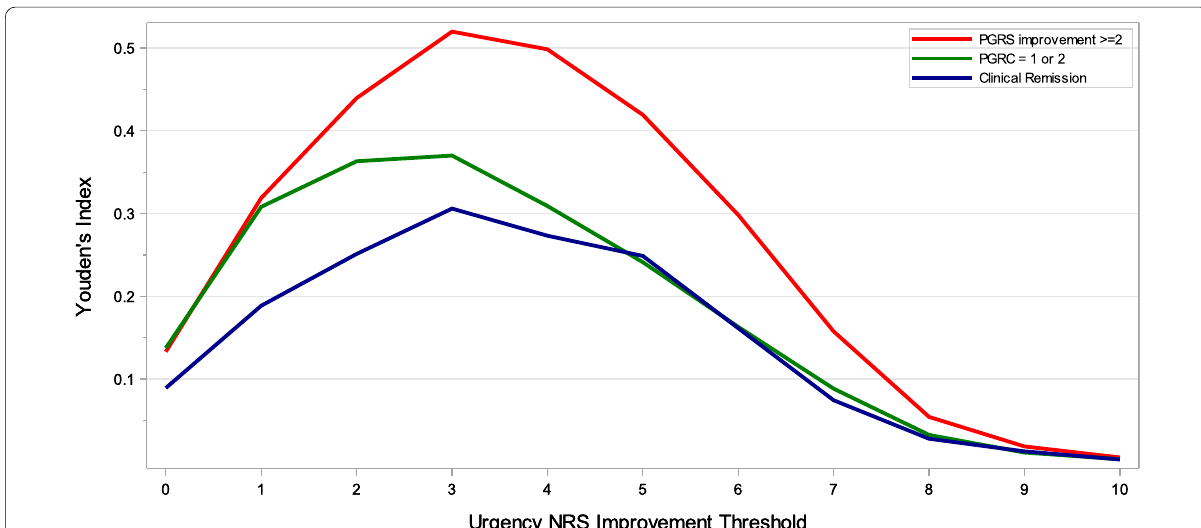
Fig. 3 Youden’s Index from an anchor-based analysis of improvement in Urgency NRS from baseline to week 12. Clinical remission was defined as a Mayo stool frequency subscore of 0, or 1 with a 1-point decrease from baseline; a Mayo rectal bleeding subscore of 0; and a Mayo endoscopic ≥ subscore of 0 or 1 (excluding